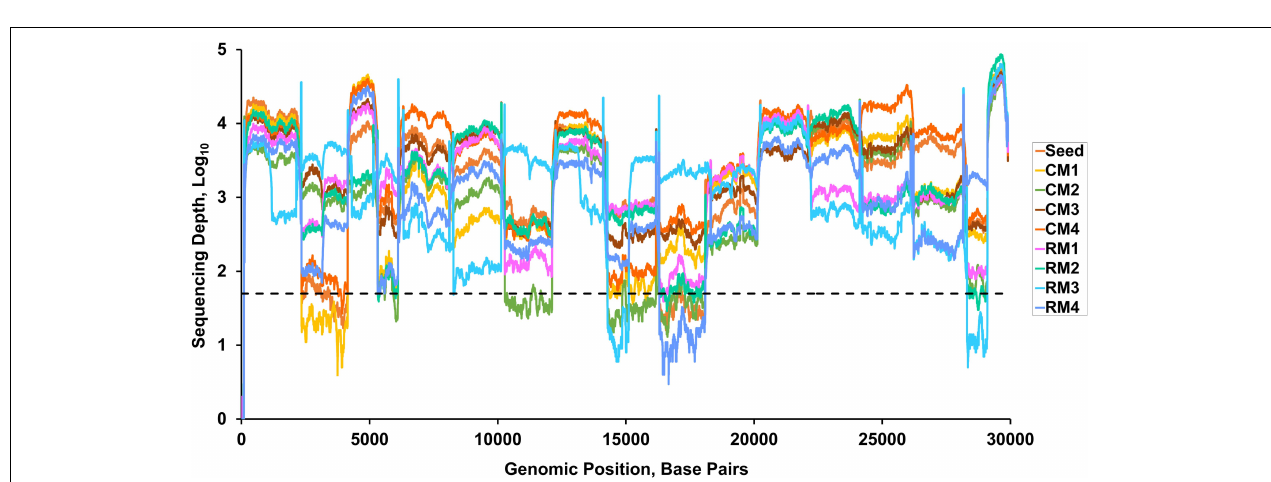
FIGURE 2 | Read depth across the whole genome of SARS-CoV-2. Dashed line indicates a read depth of 50.